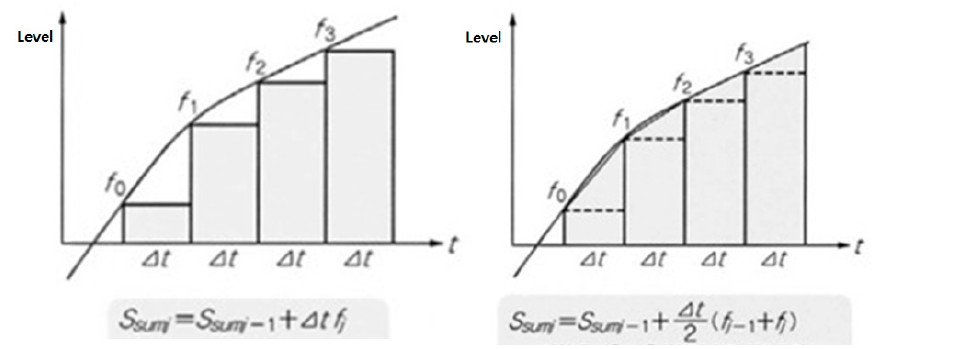
Figure 17. Trapezoid Integration.